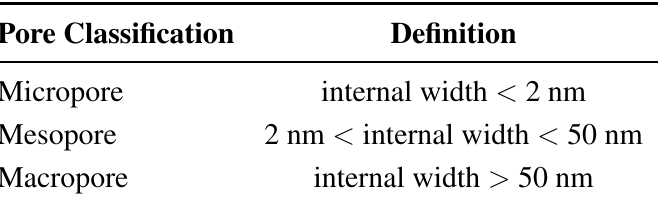
Table 9. IUPAC classification of internal pore